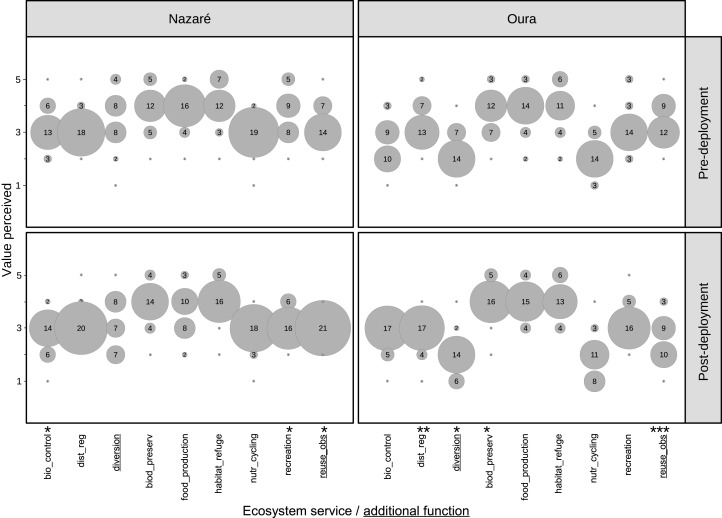
Bubble plots showing pre- and post-deployment ecosystem service and additional function perceptions found by fishermen on the ARs of Oura and Nazaré (Portugal).The diameter of each circle and the correspondent figure inside represent the number of respondents’ perception of each ecosystem service/additional function. Significance level: *p < 0.05, **p < 0.005, and ***p < 0.0005.